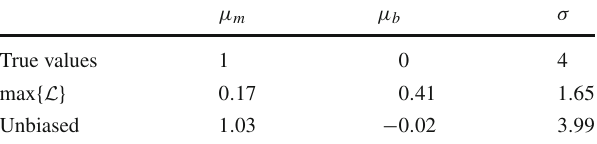
tions with μ = θ and σ = 1 (see Fig. 4). The network